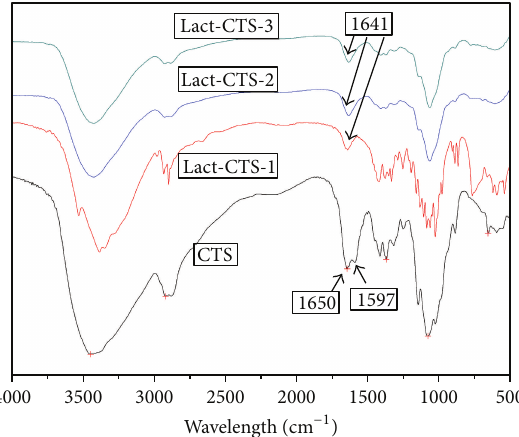
Figure 3: FTIR spectra of CTS, Lact-CTS-1, Lact-CTS-2, and Lact-